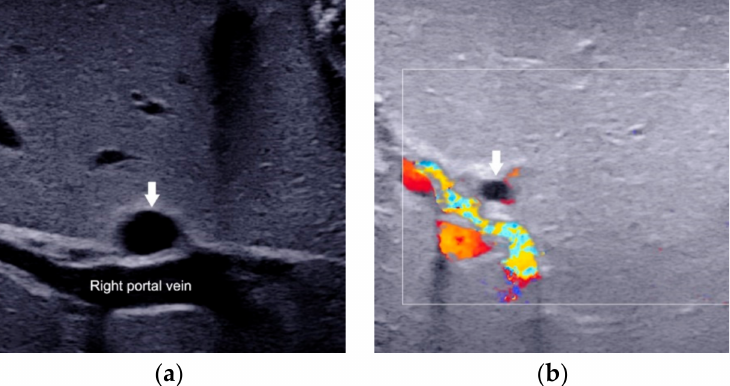
Figure 3. Porta hepatis macrocyst ( a ) and microcyst ( b ) in infants with biliary atresia.